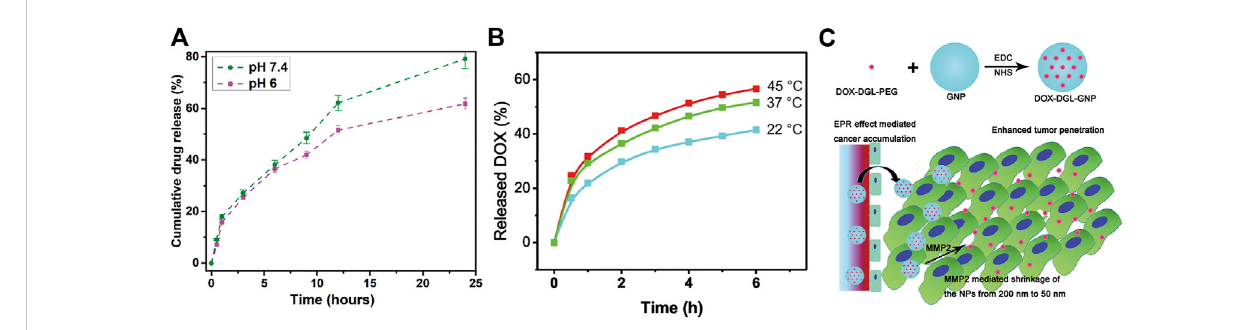
FIGURE 2 Application of gelatin DDnS in anticancer fi eld. (A) The effect of pH on the drug release rate of gelatin DDnS (Bhattacharyya et al., 2022); (B) The effect of temperature on the drug release rate of gelatin DDnS (Suarasan et al., 2016); (C) Application of MMP-2 responsiveness of gelatin in anticancer DDnS (Hu et al.,